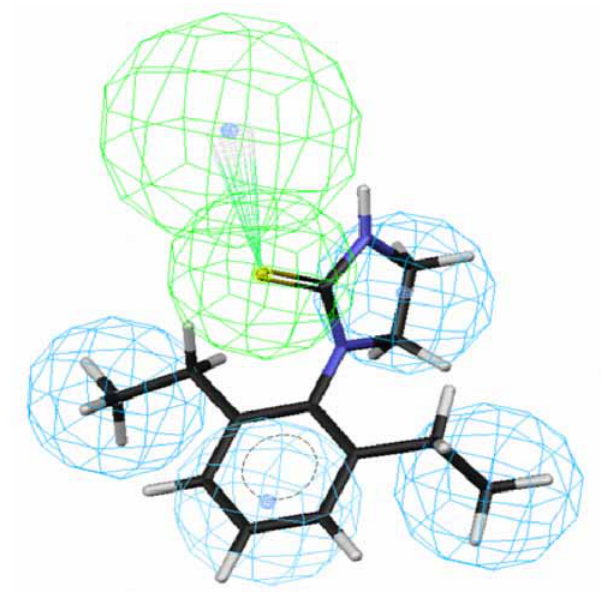
Figure 1. Mapping of 70 to hypothesis 1, which contains an HpAr (blue), three HpAls (blue) and an HBAl (green).